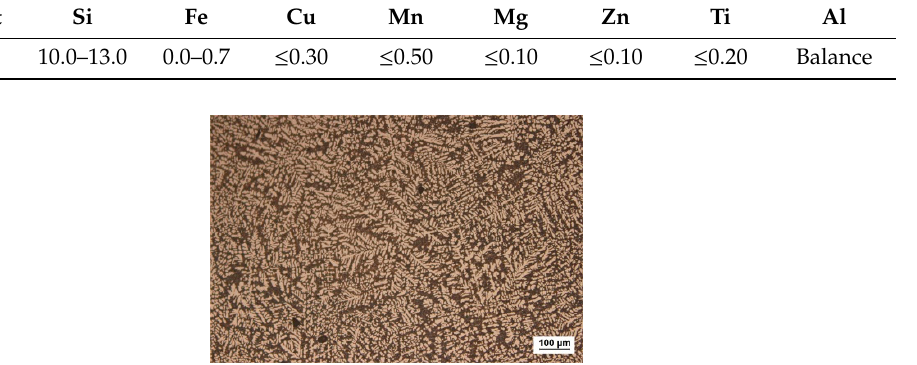
Figure 2. Metallographic structure of the as-cast brazing filler metal. Table 1. Chemical composition of ZL102 (in wt.%).